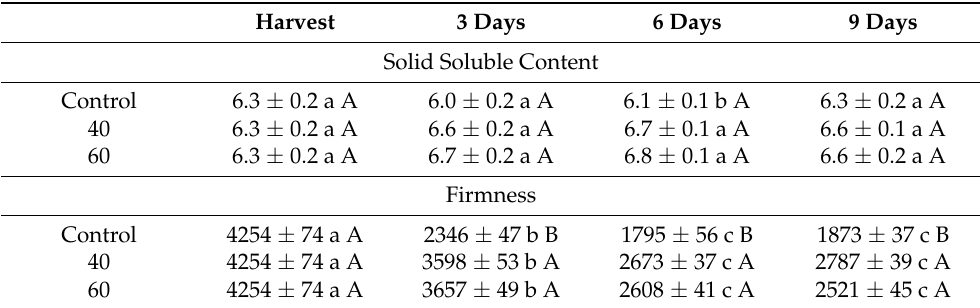
Table 1. Effect of eugenol doses on SSC (expressed as the Brix degree) and firmness (expressed in g) in Raf tomato fruits.